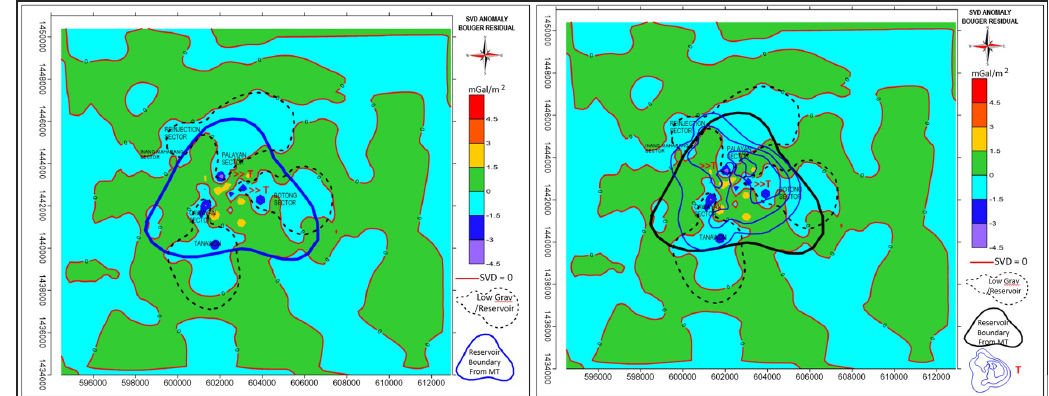
Fig. 10. SVD map of the residual Bouguer anomaly overlaid with the reservoir area derived from MT data and the reservoir prospect area derived from the Bouguer Residual anomaly data.